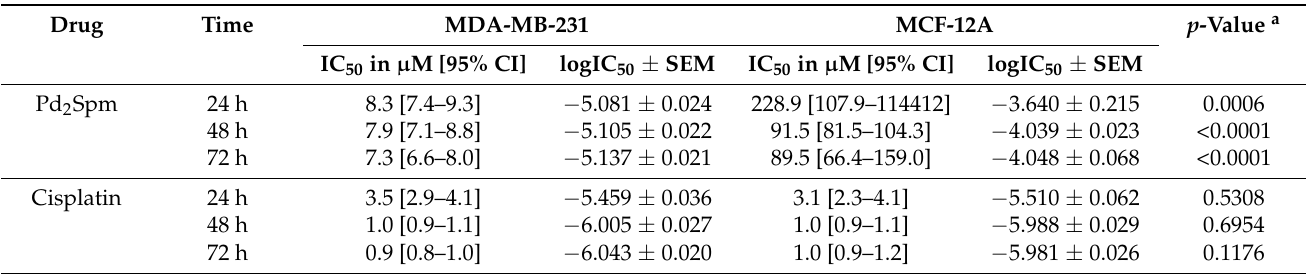
Table 1. The half maximal inhibitory concentration (IC 50 ) of Pd 2 Spm and cisplatin in triple-negative human breast cancer (MDA-MB-231) and non-cancer breast (MCF-12A) cells at 24, 48 and 72 h of incubation.